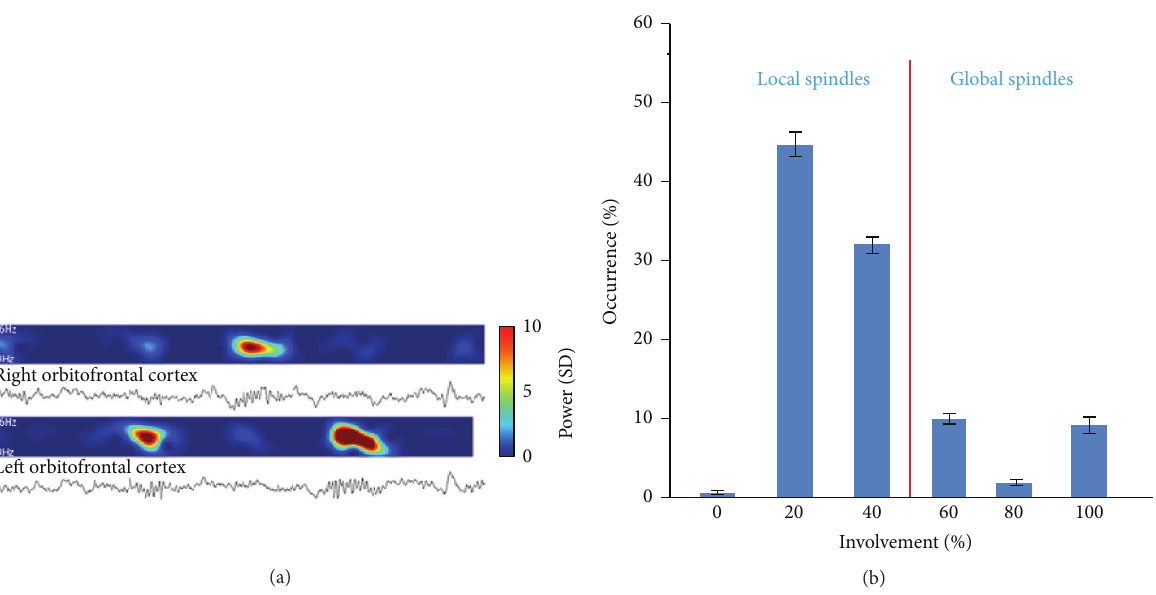
Figure 5: Local spindles. (a) An example of local spindles. Depth EEG along with corresponding spectrograms in the spindle frequency range (9–16Hz) during 15 s of slow wave sleep. (b) Distribution of involvement (percent of monitored brain structures expressing each spindle). Considering local spindle below 50 % of involvement, most sleep spindles are local (21240 spindles in 49 electrodes of 12 individuals). Modified from